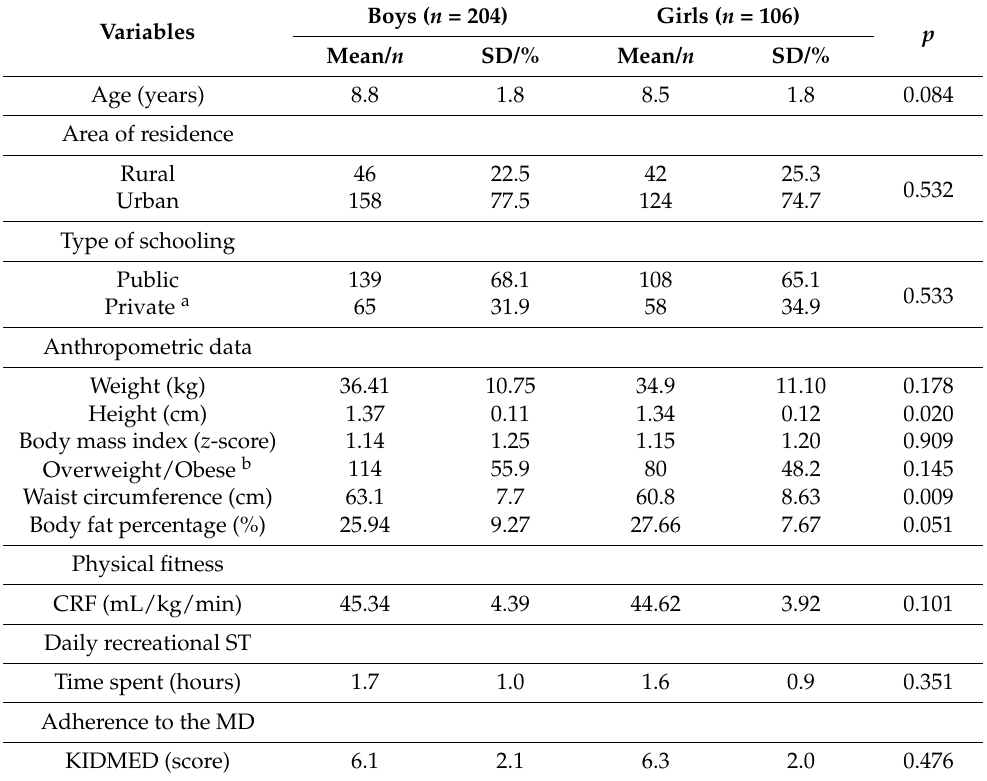
Table 1. Descriptive characteristics of the analyzed sample stratified by sex.